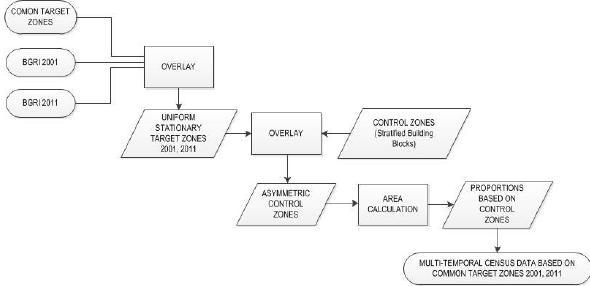
Figure 3. Flowchart with the asymmetric mapping to estimate Population in